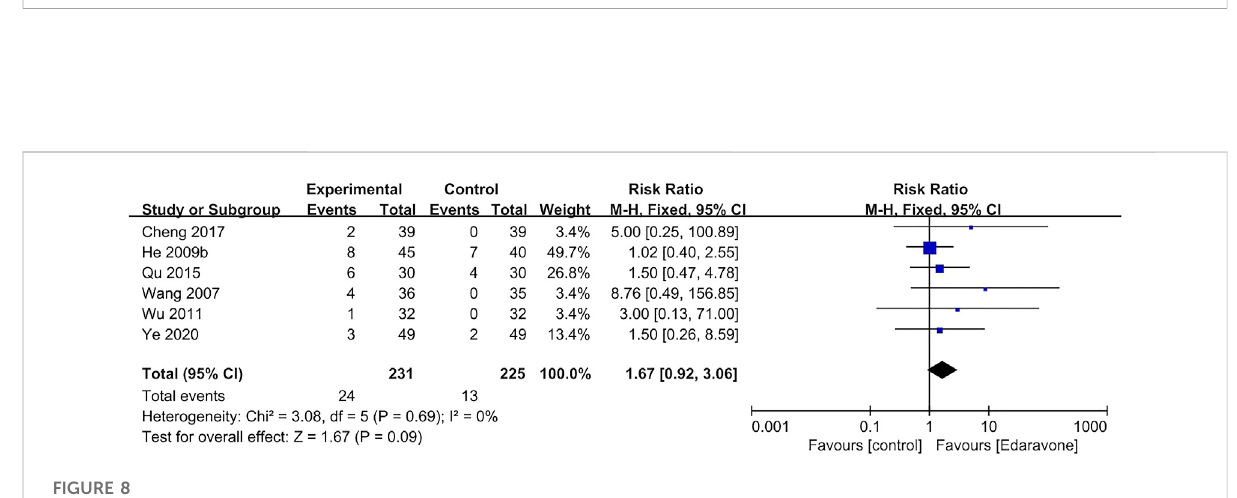
FIGURE 8 Forest plot for the effect of edaravone on adverse